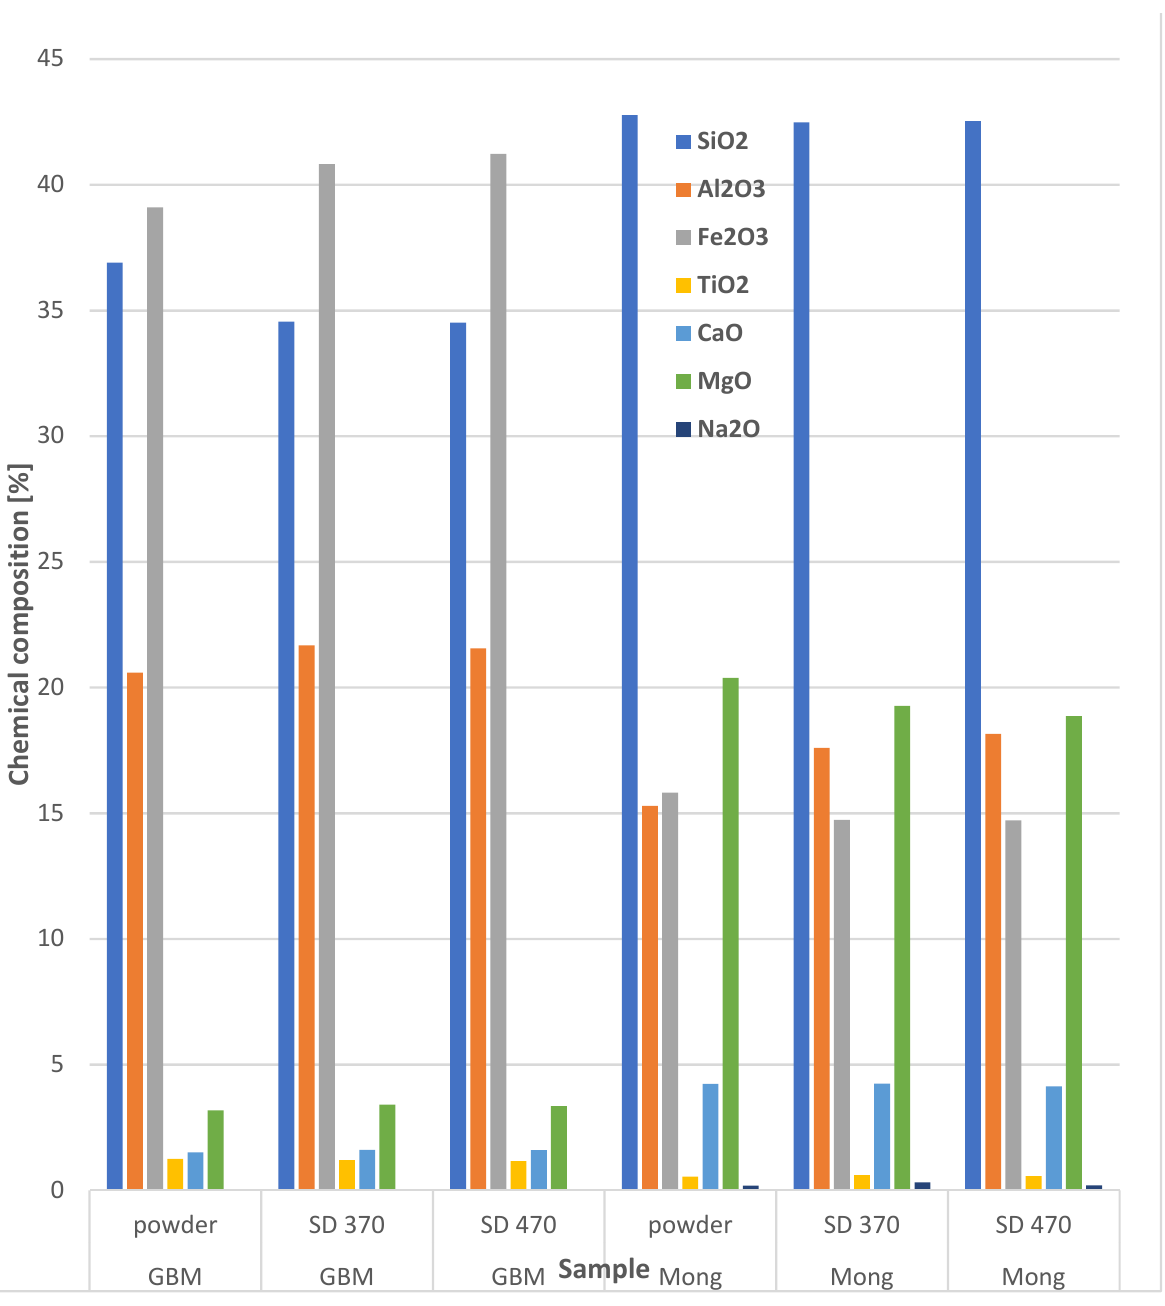
Figure 12. Content of individual simple oxides, recalculated from XRF results. When we look on the dielectric behavior of samples at elevated temperature 300 ◦ C (Figures 13 and 14—permittivity and Figures 15 and 16—losses), we see even more pro- nounced difference between the two coatings, especially because of the colossal values of GBM permittivity at low frequencies. Loss tangent of both coating became higher under SD, the SD of 370 mm achieved the relaxing character of the GBM coating. The relaxation frequency was at 200 Hz, manifesting itself by a peak on the loss tangent dependence (Figure